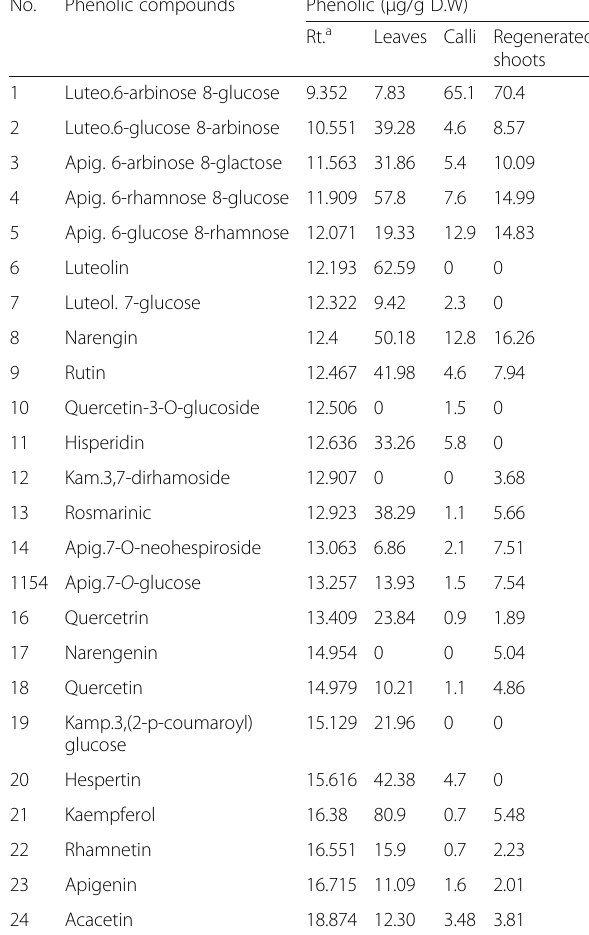
Table 5 Results of phenolic compounds identified by RP-HPLC in different extracts (80 % MeOH) of leaves, calli, and regenerated shoots of Diospyros kaki L. cv. Costata that appeared at λ max 330 nm